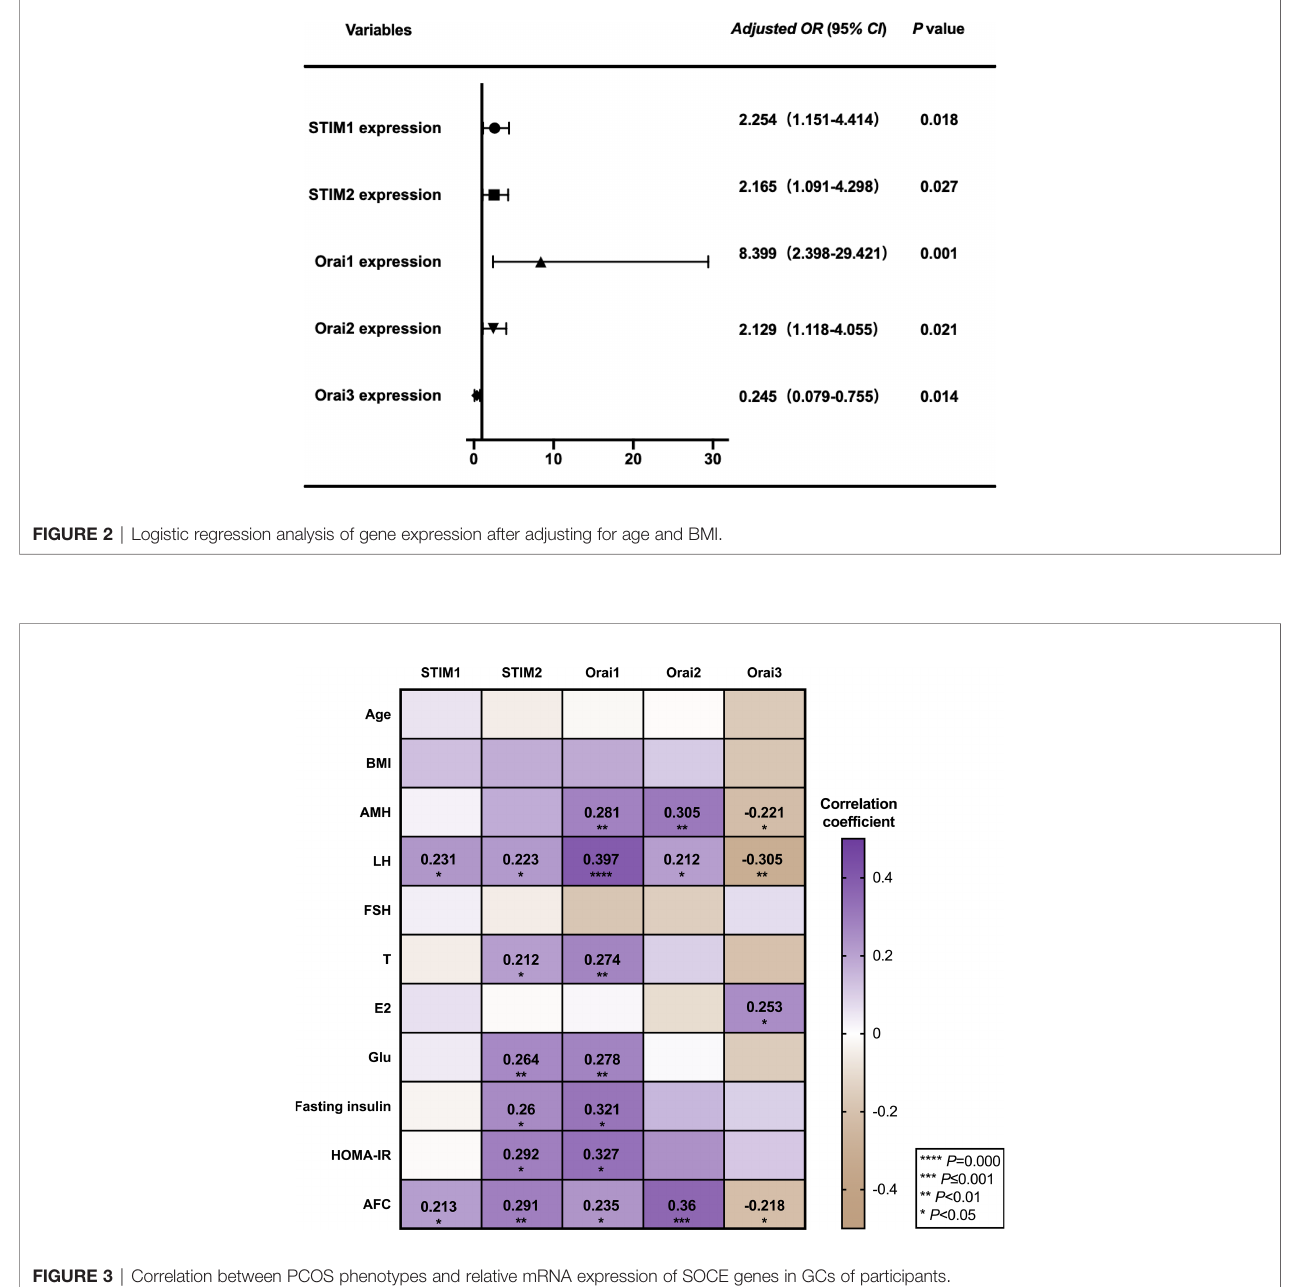
FIGURE 3 | Correlation between PCOS phenotypes and relative mRNA expression of SOCE genes in GCs of